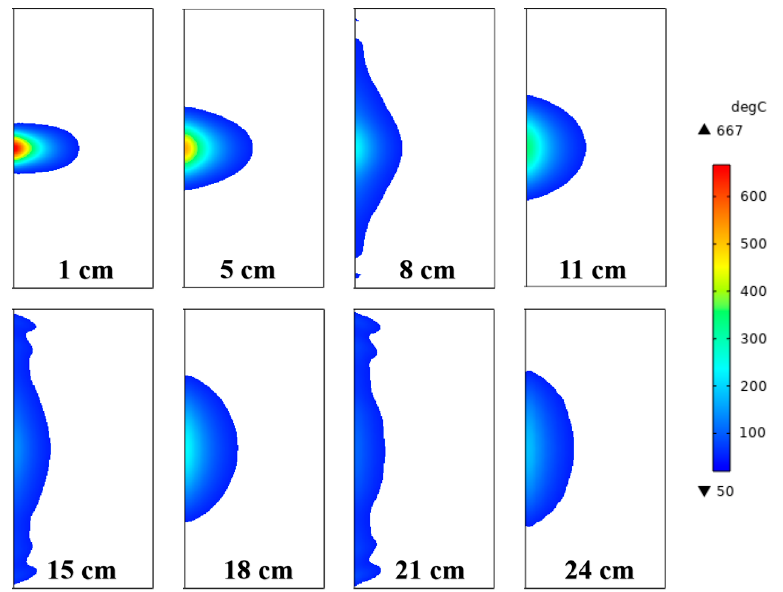
Figure 6. Temperature distribution in the rock sample under different irradiation distances.